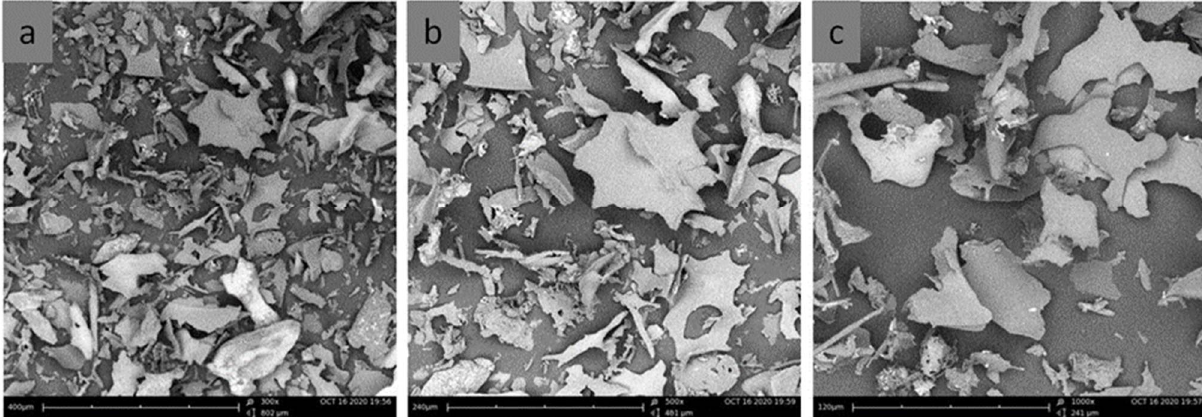
Figure 3. SEM images of the freeze-dried nisin-loaded ulvan particles at ( a ) ×300, ( b ) ×500 and ( c ) ×1000 magnification. For particle preparation, the concentrations of ulvan and nisin were 0.4 mg/mL at pH 6.0. FT-IR spectroscopy was used to investigate the interaction between nisin and